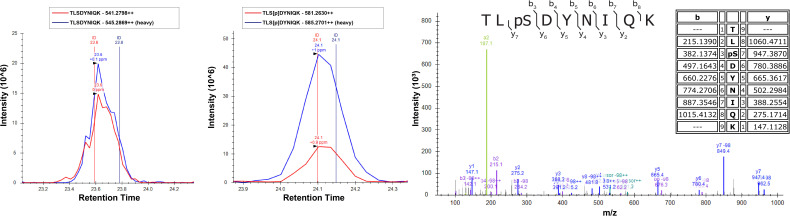
Overexpression of Vhs1 in yeast cells increases Ser57 phosphorylation of ubiquitin.Cells were grown in SILAC media supplemented with light or heavy lysine and arginine. Chromosomally expressed 3xFLAG-tagged ubiquitin (from the RPS31 and RPL40B loci) was isolated by affinity purification and digested with trypsin. Phosphopeptides were enriched by immobilized metal affinity chromatography (IMAC), separated by a capillary reverse-phase analytical column, and analyzed on a Q Exactive mass spectrometer. Theoretical masses of b/y ions are tabulated and MS-observed masses are shown in the spectra.